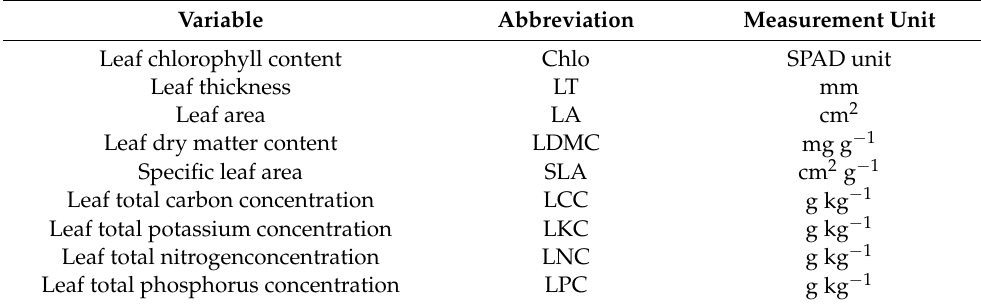
Table 1. Summary of the variables, abbreviations, and measurement units of functional traits.